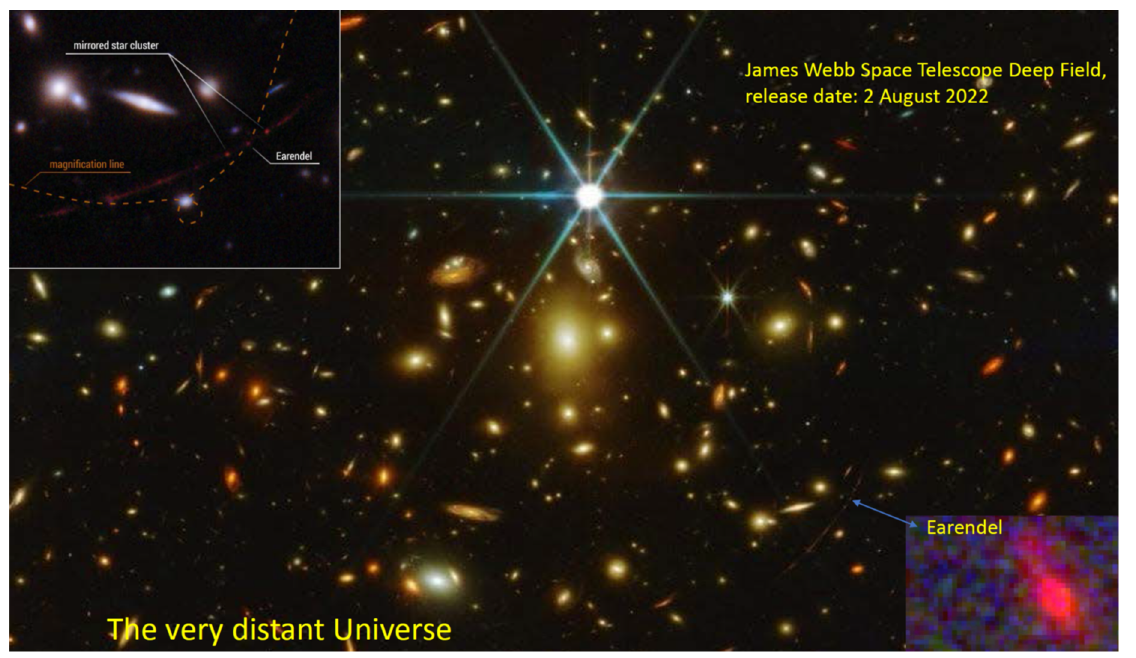
Figure 5. The very distant Universe. James Webb Space Telescope Deep Field, release date: 2 August 2022. Earendel is to be seen at the crossing of two gravitational lenses images.